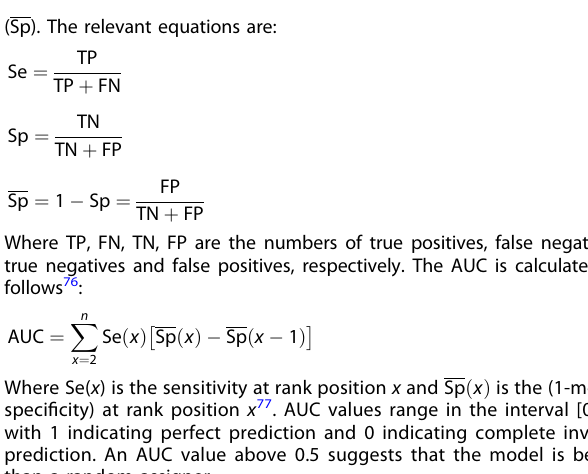
Fig. 5 Results of DFT and TD-DFT calculations for TSC6, ASC5 and TA-DM-CA. a HOMO/LUMO energy diagrams and structures. b Absorption spectrum for TSC6 . c Absorption spectrum for ASC5 . d Absorption spectrum for TA-DM-CA